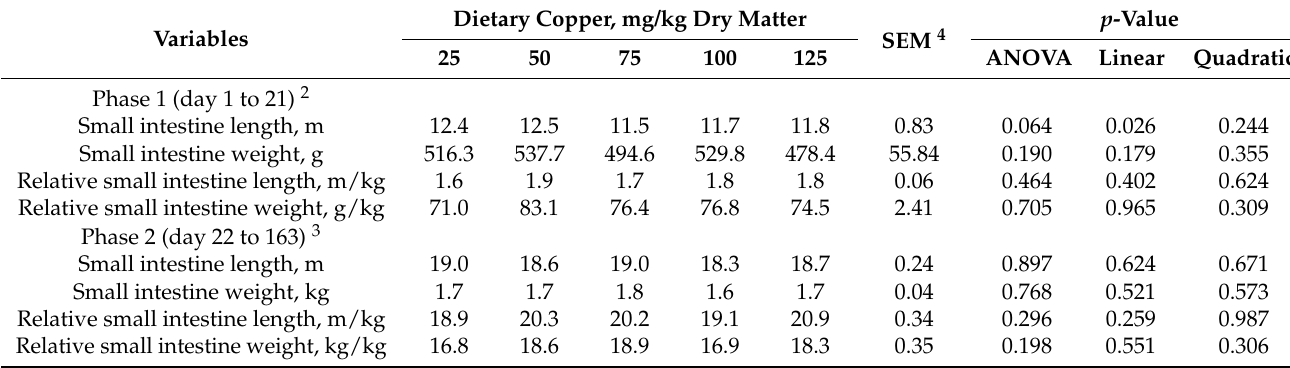
Table 2. Effects of dietary copper supplementation during the weaning period on the small intestinal index of weaned and finished pigs 1